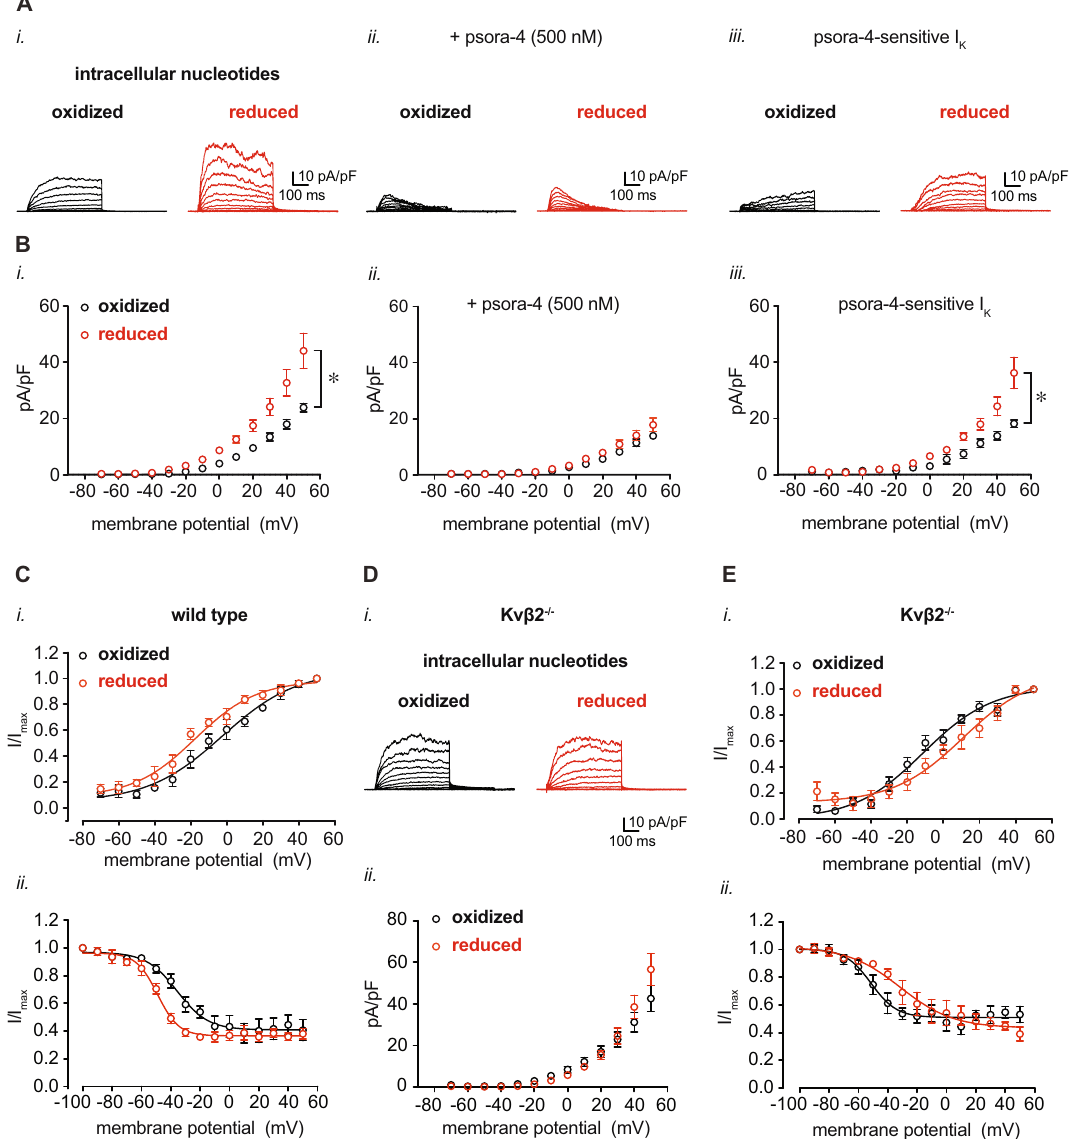
Fig. 3 Modulation of coronary arterial myocyte I Kv upon changes in intracellular pyridine nucleotide redox potential. Isolated coronary arterial myocytes were dialyzed with pyridine nucleotides at concentrations as indicated in Supplementary Table 2 for voltage-clamp recordings in the conventional whole- cell con fi guration. A , B Representative outward K + currents ( A ) and I K densities (pA/pF; B ) recorded in coronary arterial myocytes from wild type mice (129SvEv) in the presence of either oxidized or reduced pyridine nucleotide redox ratios. Recordings were performed in the absence (i.) and presence (ii.) densities (mean values ± SEM) are shown in iii. panels. n = 5 – 6 cells, 4 – 5 mice for each. * P < 0.001, oxidized vs. reduced (mixed effects